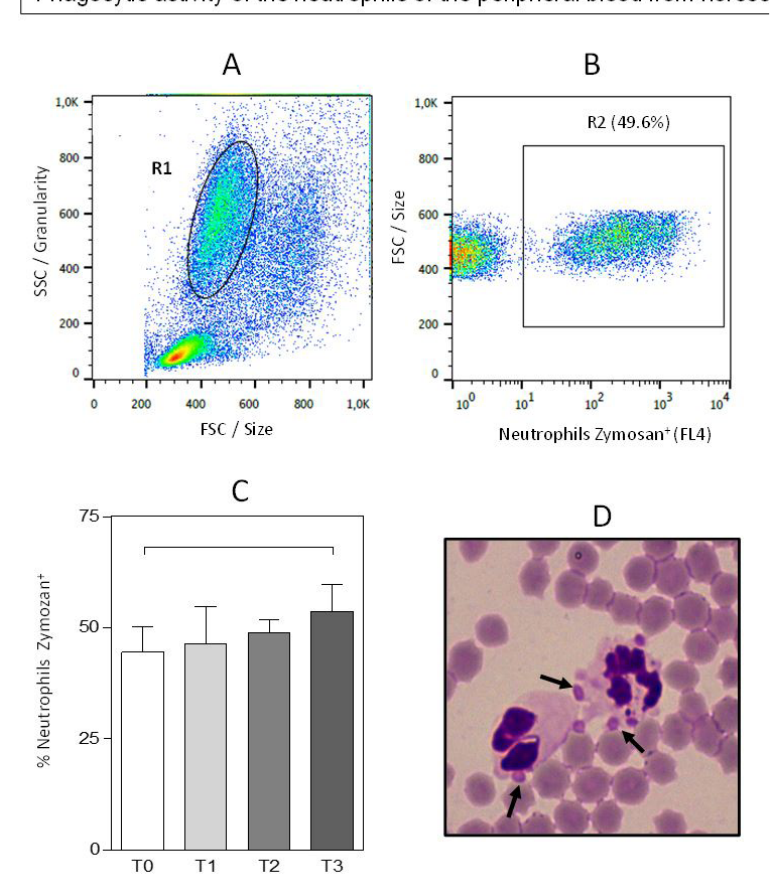
Figure 3. Phagocytic neutrophil activity in horses submitted the autohemotherapy. Flow cytometry